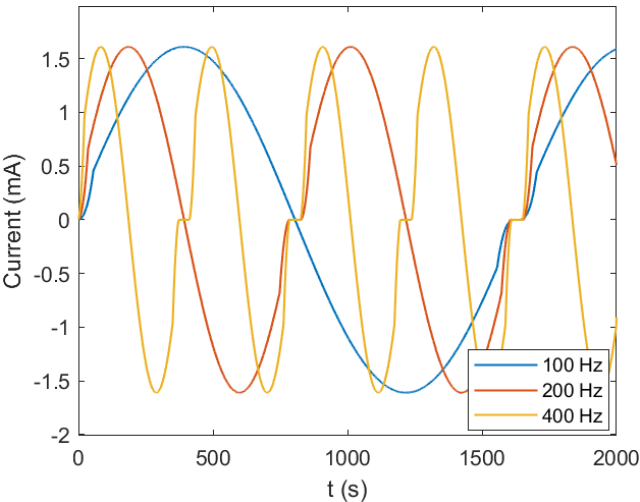
Figure 8. Current signal (response) for different frequencies, as obtained from the simulation. The three different frequencies are shown in different colors and correspond to the ones shown in Figure